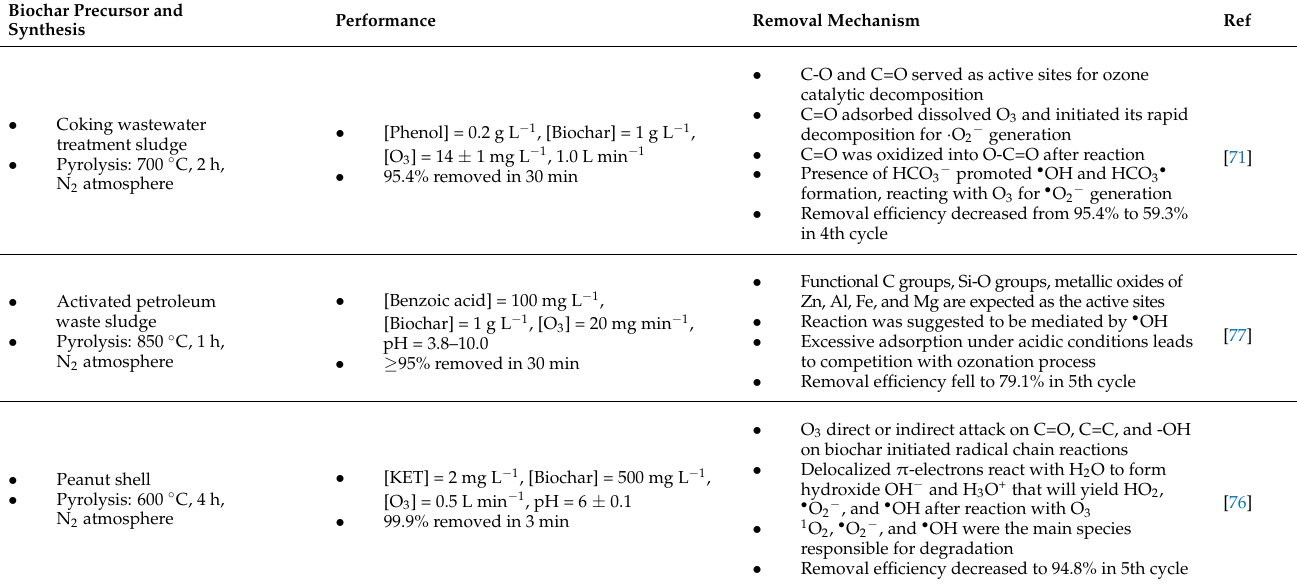
Table 3. An overview of biochar preparation and performance in O 3 activation for organic pollutants